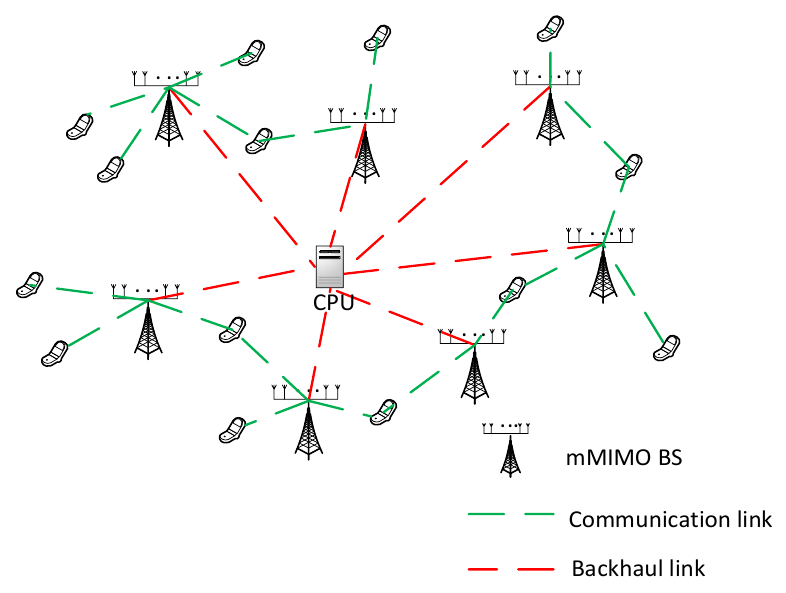
Figure 7. An illustration of Cell-free Massive MIMO.